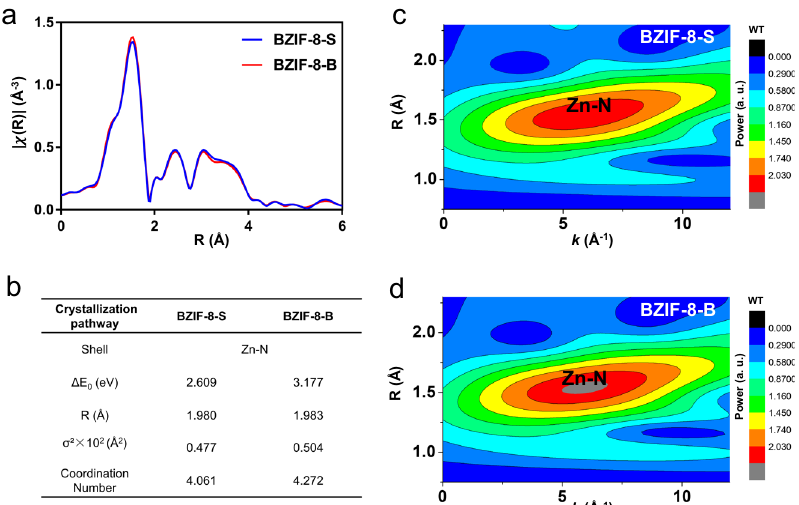
Fig. 4 Coordination structure pro fi les. a The Fourier-transformed (FT) – EXAFS spectra of BZIF-8-B and BZIF-8-S. b The data obtained from fi tting XAFS spectra to pure ZIF-8 crystal f eff path. Δ E 0 : the inner potential correction; R: bond distance; σ 2 : mean square racial displacement, Debye-Waller factor. The wavelet transform spectra of BZIF-8-S ( c ) and BZIF-8-B ( d ) from the K-space data. The intensity maximum in R and K space re fl ected the coordination number of the Zn atoms. WT means wavelet